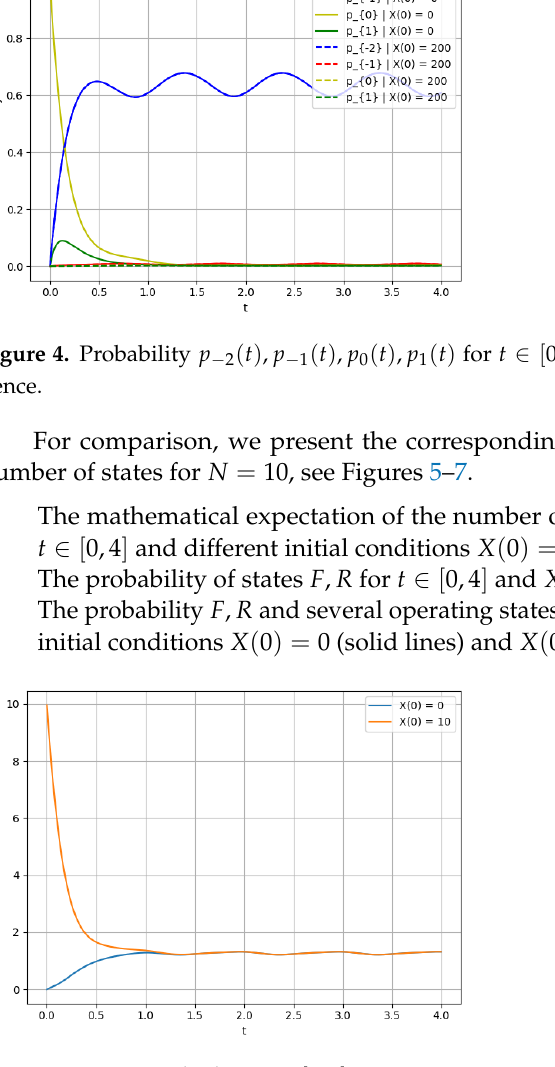
Figure 5. Average E ( t , k ) for t ∈ [ 0,4 ] at N =